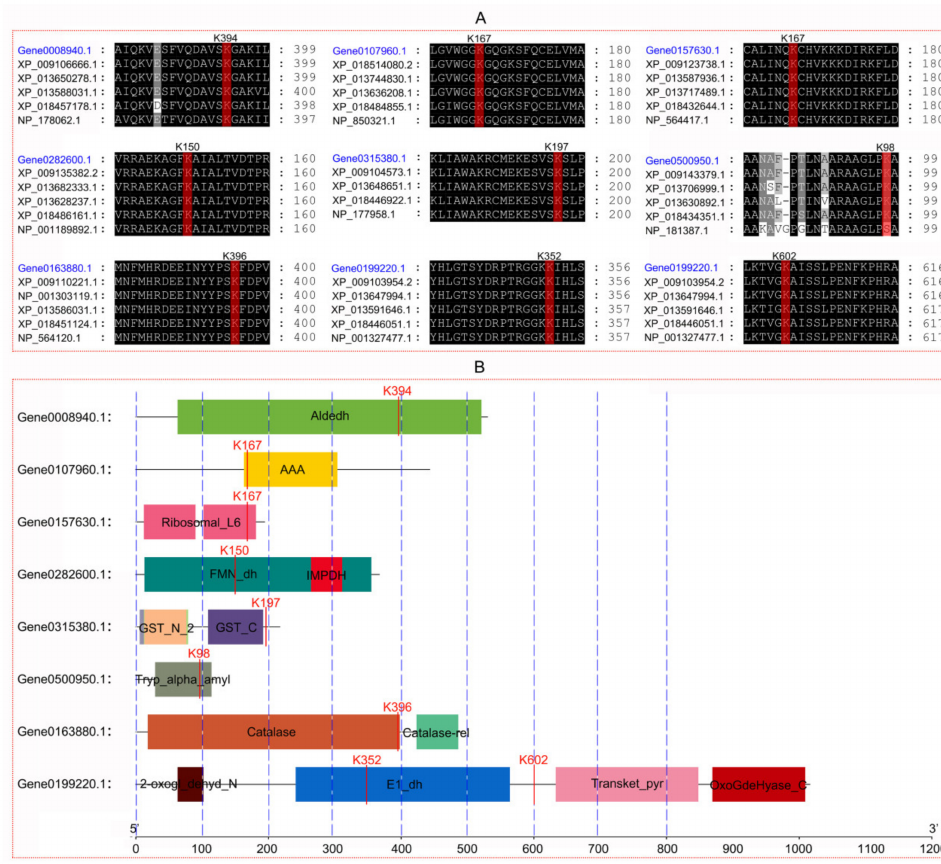
Figure 5. Conservatism and location analysis of the differentially succinylated sites (DSSs) identified in the shoots of turnip seedlings under Cd treatment. ( A ) Alignment of the DSSs with homologous protein sequences in different Brassicaceae plants. The identifiers following the target protein accession (in blue) from top to bottom represent the accession No. in NCBI of the corresponding homologous proteins from Brassica rapa , B. napus , B. oleracea var. oleracea , Raphanus sativus , and Arabidopsis thaliana . The homologous protein from B. oleracea var. oleracea for Gene0315380.1 is missing in this study; ( B ) The positional relationships of the DSSs with conserved protein domains. The conserved domains were searched using the Pfam tool (http://pfam.xfam.org/search#tabview=tab1, accessed on 27 July